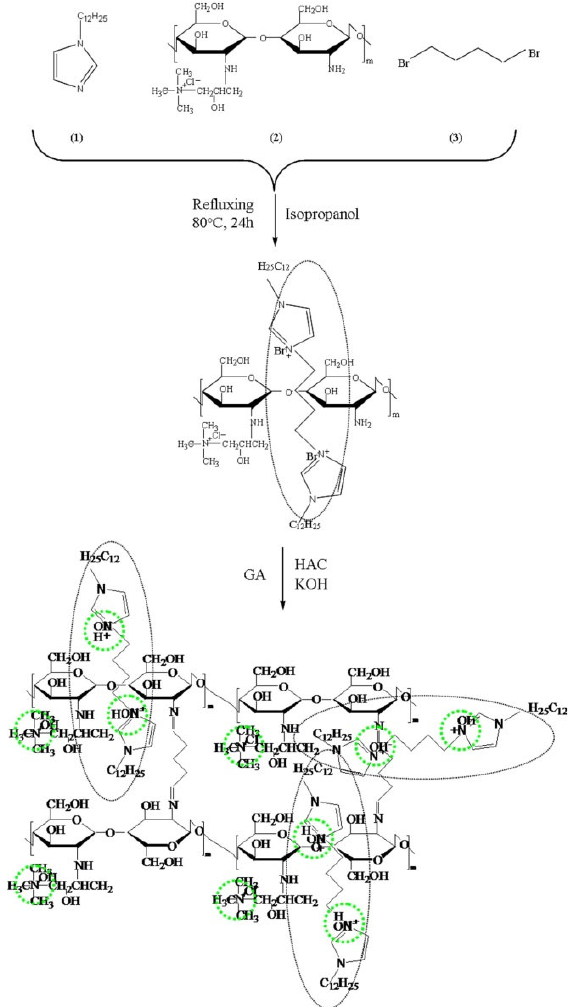
Figure 3. Synthetic procedure for anion exchange membranes. Reprinted with permission from Ref. [17]. Copyright 2015 Elsevier.